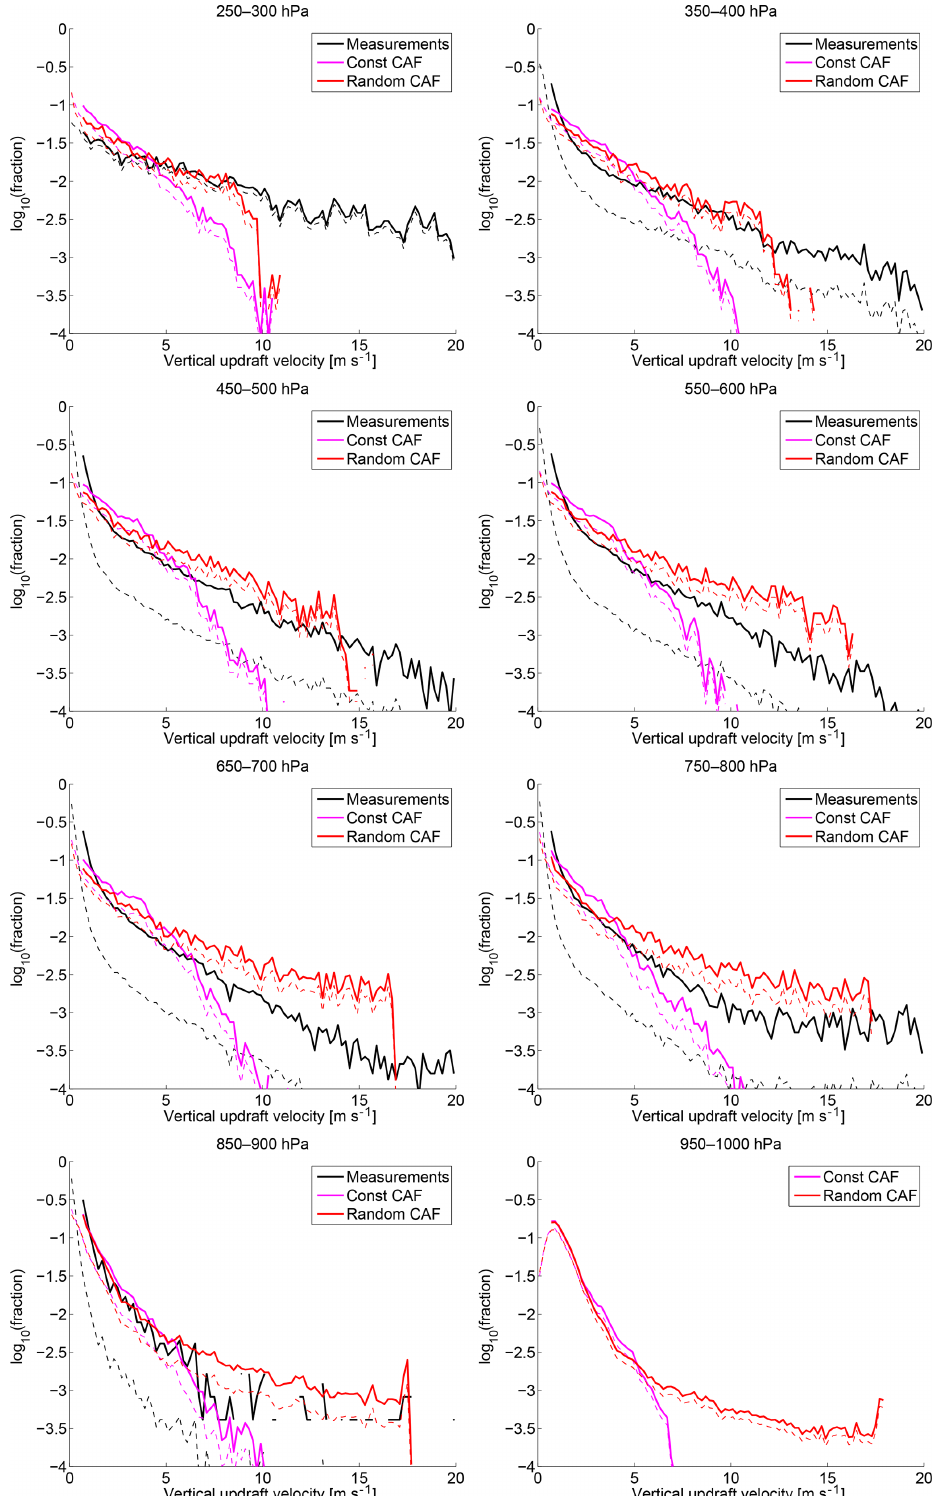
Figure 11. Frequency distribution of vertical updraft velocities for different pressure bins from wind profiler measurements in Darwin, Australia, in 0.2ms − 1 bins (black) compared to the corresponding frequency distributions of vertical updraft velocities obtained from the constant and random convective area fraction profile method (magenta and red). The dashed lines show the distribution including all velocity values ( > 0ms − 1 ); for the solid lines all values below 0.6ms − 1 are